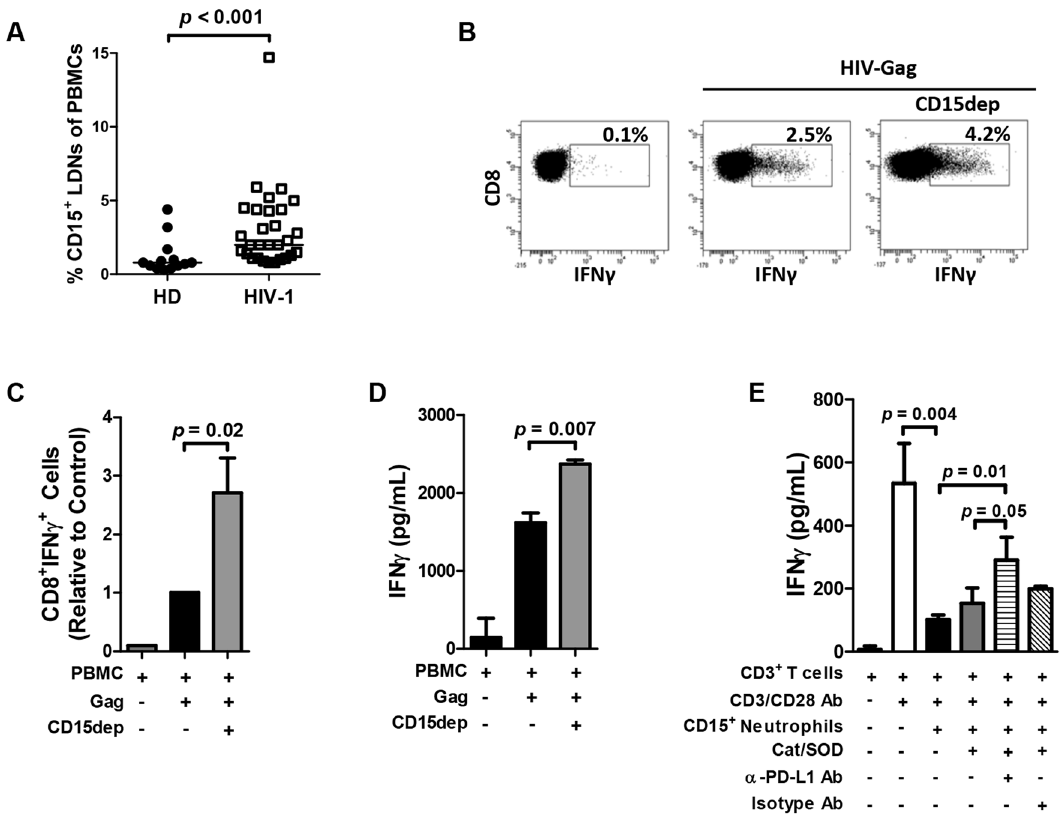
Figure 2. Neutrophil suppression of T cell function is mediated in part via the PD-L1/PD-1 pathway. A) PBMCs of HIV-1-infected individuals display higher frequency of CD15 + LDNs compared to healthy donors (N=13 and 29). Statistical analysis was performed using the